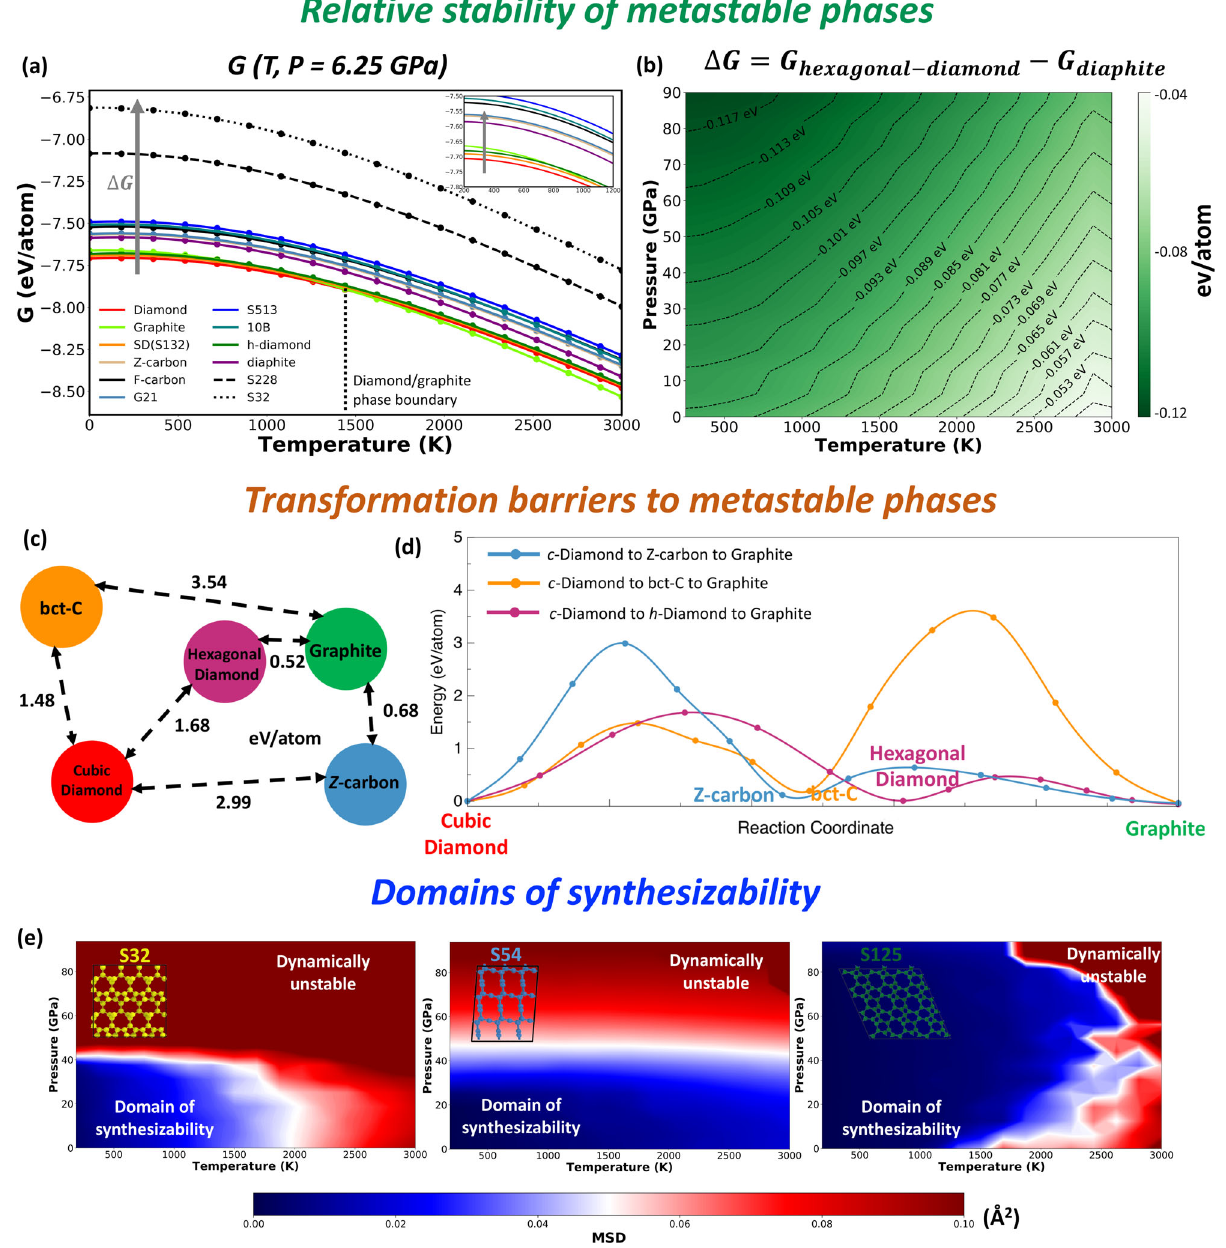
Fig. 4 Information extracted from metastable phase diagram. Relative stability of metastable phases: ( a ) G ð T ; P ¼ 6 : 25GPa Þ of equilibrium and some representative metastable phases; ( b ) Relative stability between hexagonal diamond (green) and diaphite (purple) computed as Δ G ¼ G hex - diamond (cid:3) G diaphite . d Transformation barriers to hexagonal diamond, bct-Carbon and Z-carbon metastable phases, starting from cubic-diamond and graphite, are used to construct a discrete ( c ) thermodynamic graph representing the transformation pathways and their respective barriers. e Domains of synthesizability based on dynamical stability for metastable phases S32, S54, and S125,